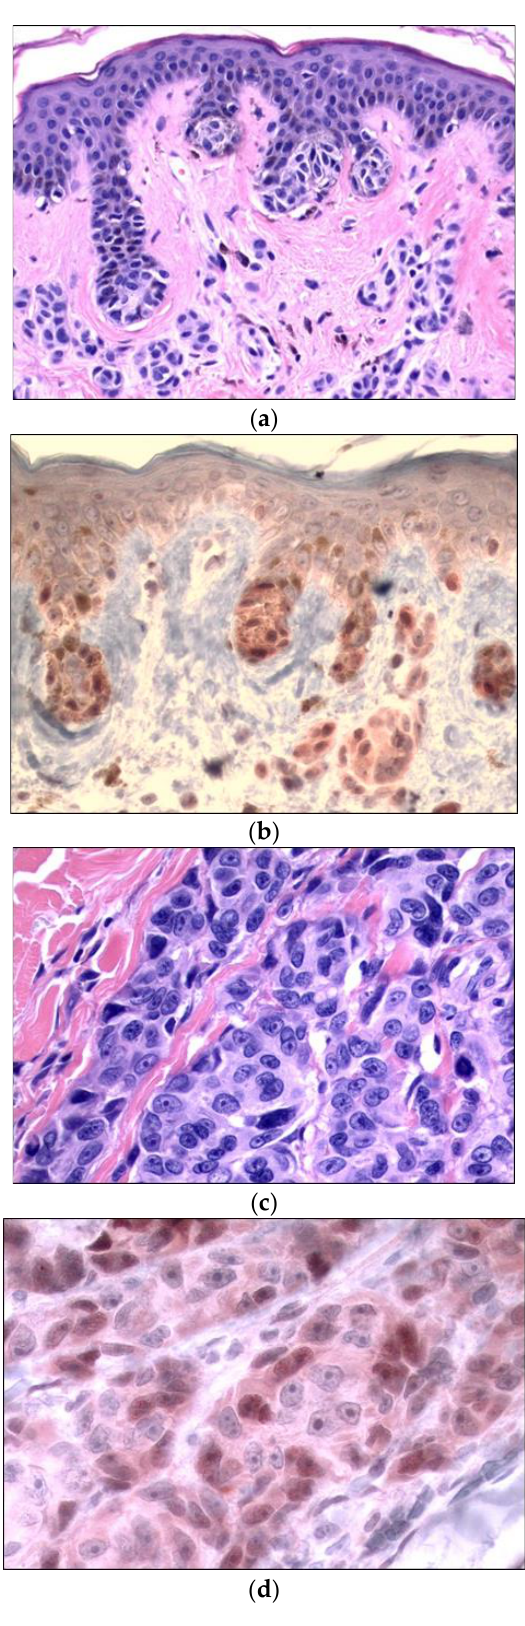
Figure 3. H&E ( a , c ) and gankyrin expression ( b , d ) in a melanocytic nevus ( a , b ) and in a nodular melanoma ( c , d ). The localization of gankyrin is predominantly nuclear in the nevus, and both nuclear as well as cytoplasmic in the melanoma. Original magnifications 200× ( a , b ), 400× ( c , d ).